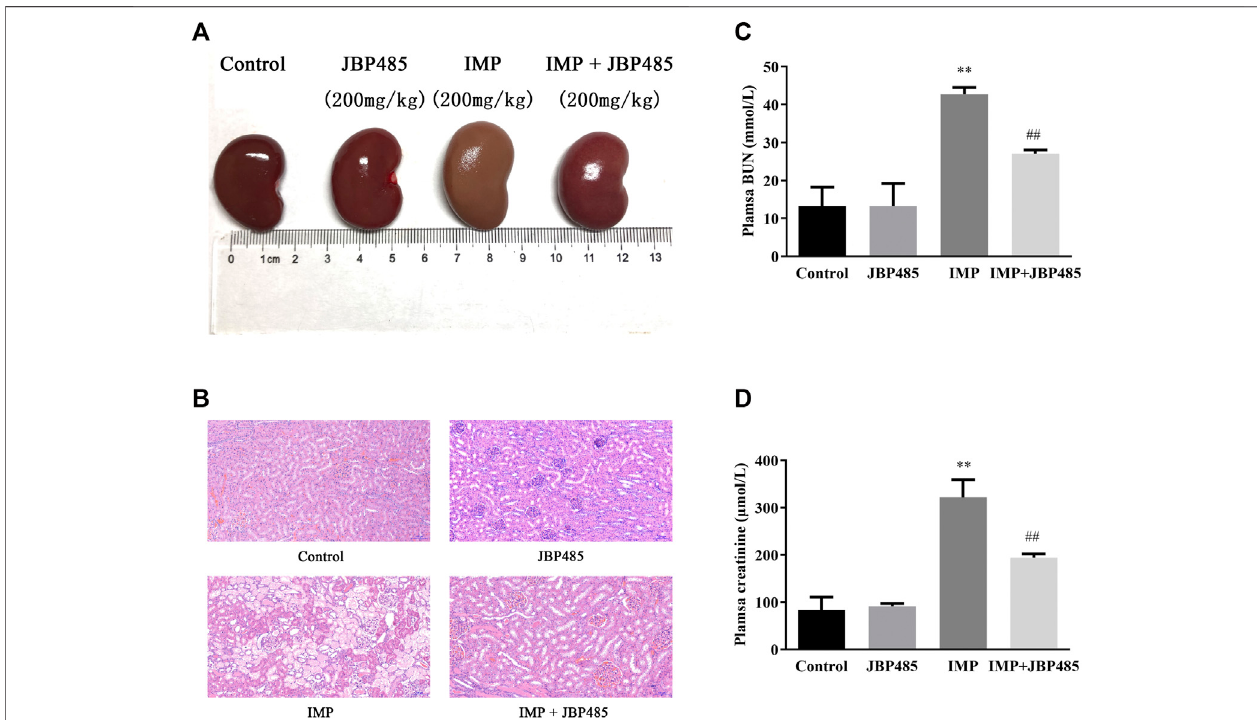
FIGURE 1 | Protective effect of JBP485 on IMP nephrotoxicity in rabbits. Rabbits were injected with IMP (200 mg/kg) through the ear vein in the absence or presence JBP485 (200 mg/kg). The kidneys were collected 72 h after administration of IMP for gross histological observation (A) and HE staining (B) . Blood samples (0.5 ml) were collected for the determination of BUN (C) and CRE (D) . Data are expressed as the mean ± SD. ** p < 0.01 compared with control; ## p < 0.01 compared with IMP group ( n =